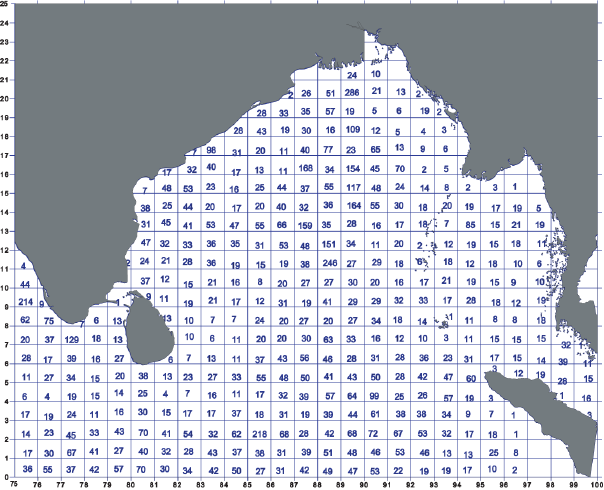
Figure 1. Spatial distribution of total number of temperature and salinity profiles available on a 1 ◦ latitude by 1 ◦ longitude grid. Table 1. Total number of temperature and salinity profiles in the Bay of Bengal for each month from January to